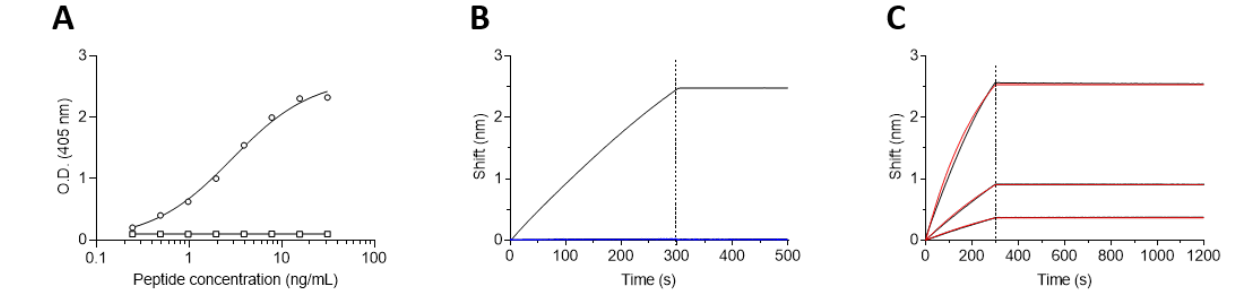
Figure 4. Specificity and affinity of SNAP1. ( A ) Streptavidin-coated ELISA plates were loaded with increasing concentrations of either Bio-P1 (circles) or Bio-P2 (squares) peptides and the binding of SNAP1 antibody was determined. ( B ) Octet Red BLI sensors were loaded with either Bio-P1 (black line) or Bio-P2 (Blue line) peptides. SNAP1 antibody was interacted with the sensors for 300 s, followed by a wash (200 s). ( C ) Bio-P1 peptide was immobilized on a streptavidin-biosensor and reacted for 300 s (association phase) with increasing concentrations of SNAP1 antibody (black lines; from bottom up: 6.7 nM, 20 nM, and 60 nM). The sensors were then immersed in buffer for another 900 s (dissociation phase). Red lines: curve fitting of the 1:1 binding model.